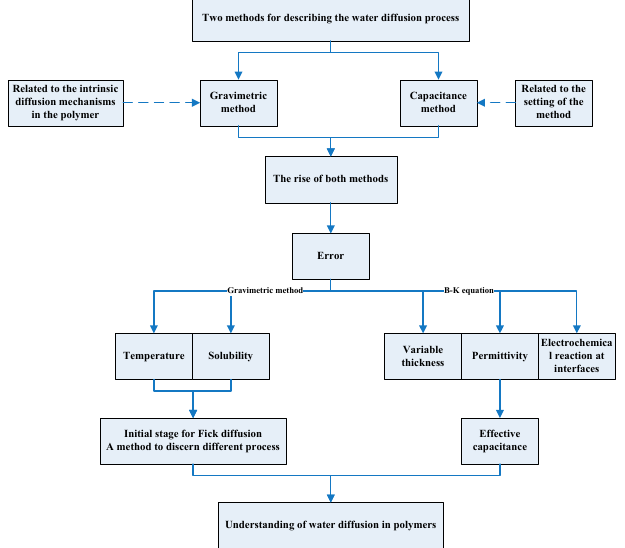
Figure 1. A diagram for this review.